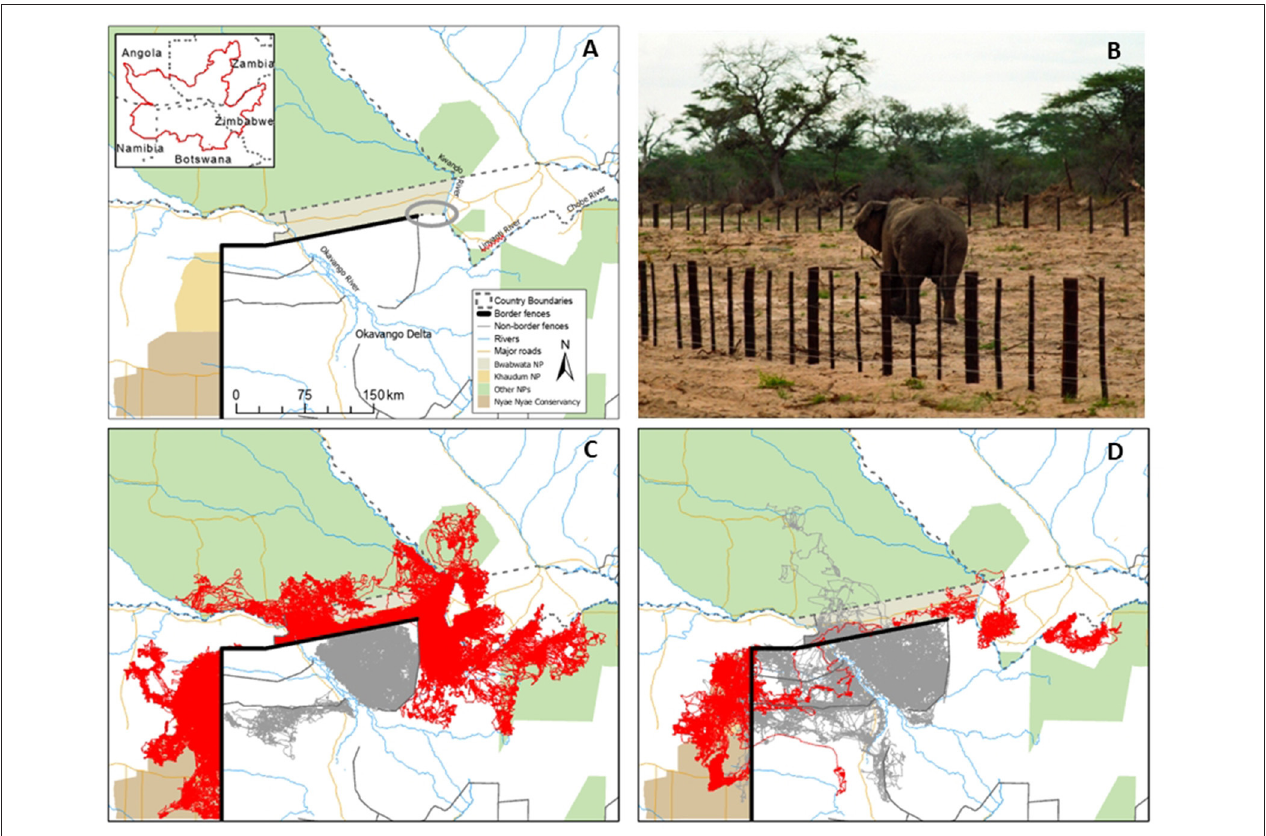
FIGURE 1 | Map of the Kavango-Zambezi study area, with an unfenced section of the border between Namibia and Botswana circled (A) , illustrative photograph of a male elephant crossing a section of the Namibia-Botswana border fence (B) , and maps of the movements of female (C) and male (D) elephants in the study area, with line color indicating those animals collared in Namibia (red) and Botswana